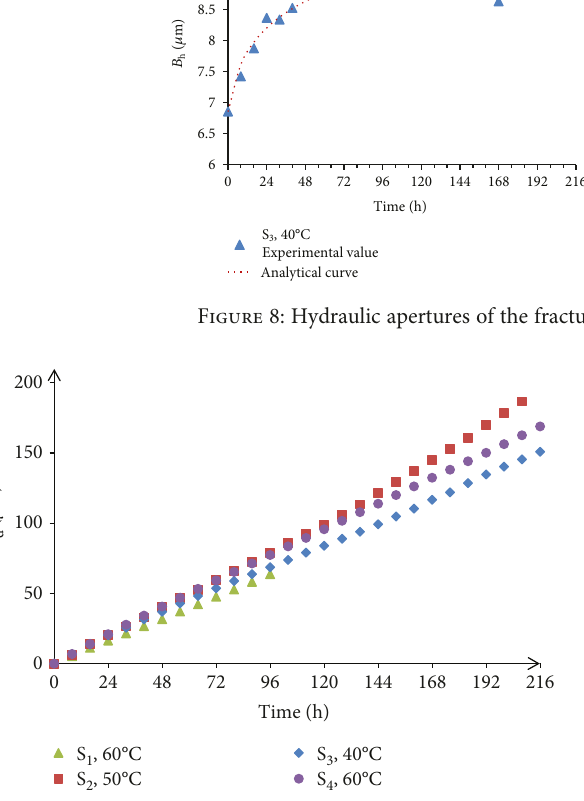
Figure 9: Dissolution apertures of the fractures over time during the CFDE